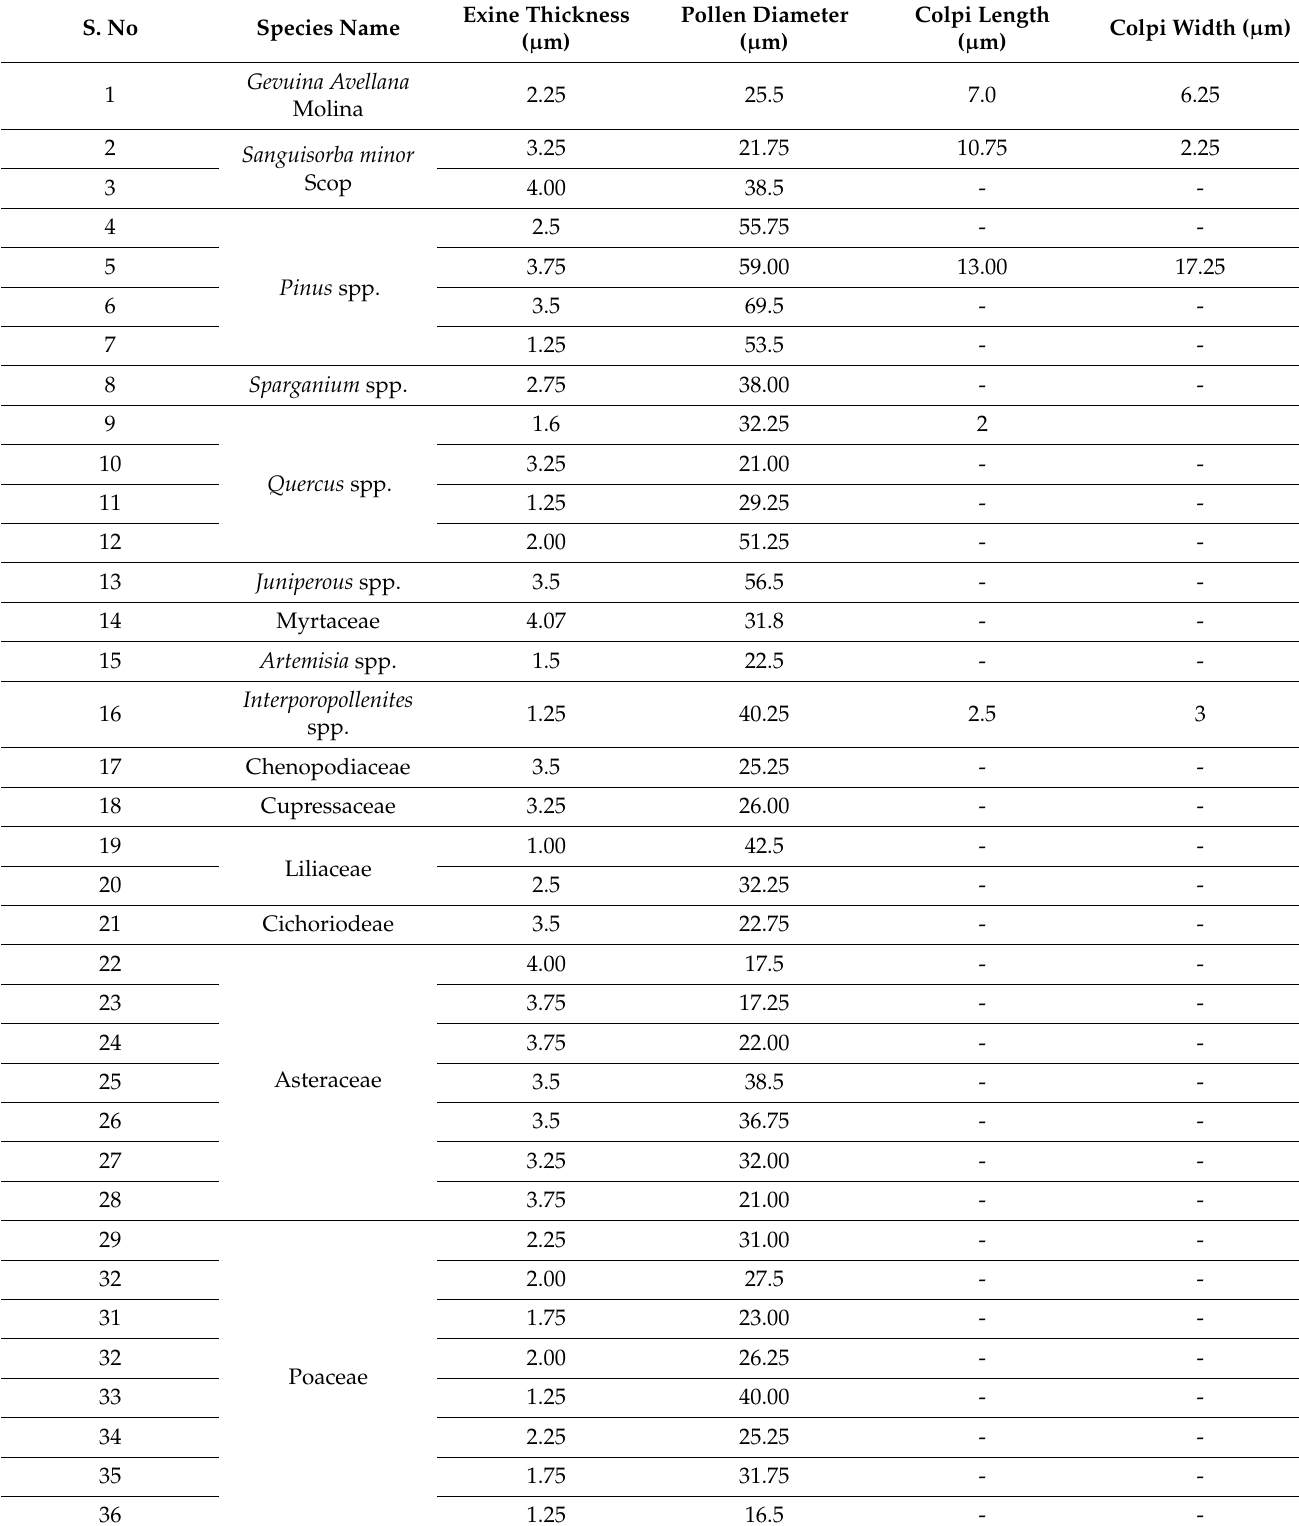
Table 2. Quantitative features of fossil plants pollen from the Murree Formation,